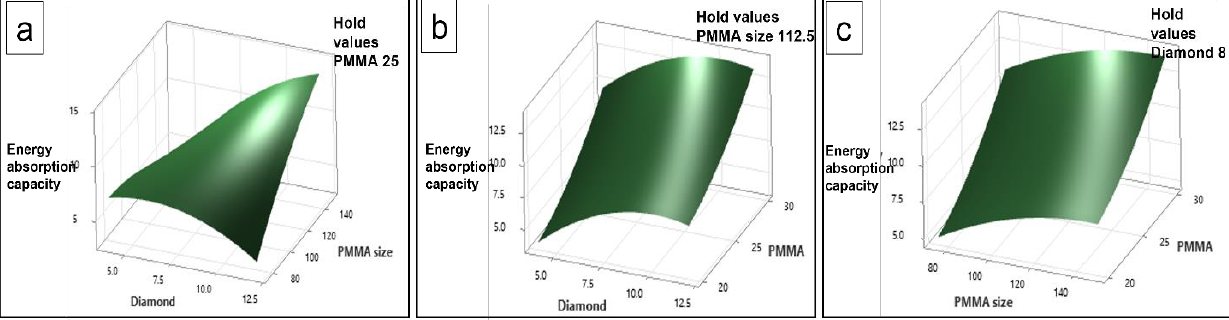
Figure 17. Comparison of confirmation test result at optimal input factors and maximum value ob- tained from Taguchi L9 runs.